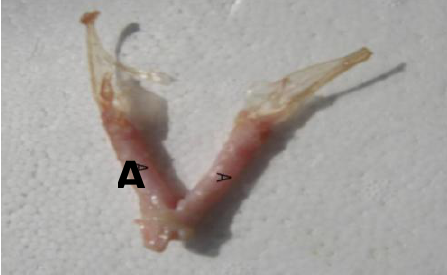
Figure 1: In buck the accessory sex gland related to pelvic urethra (PU), urinary (UB), ductus deferens (D), ampullae (A), vesicular gland (S), bulbourethral gland (B) and ejaculatory apparatus (J).